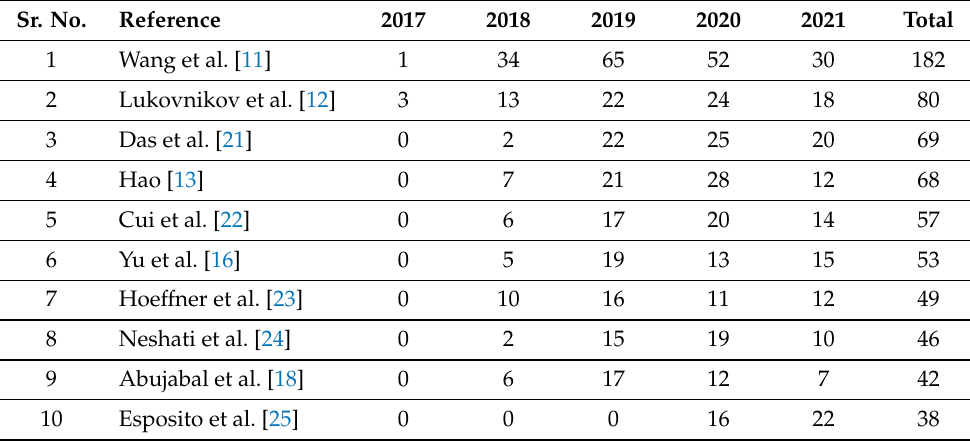
Table 4. Highly cited publications in the last five years